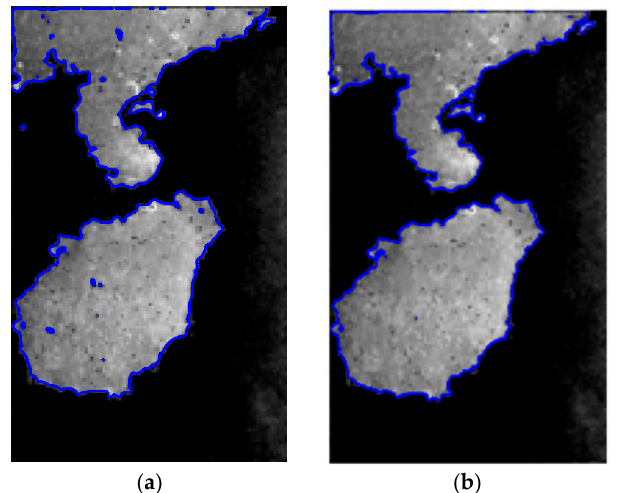
Figure 11. Comparison of whole block tracking: ( a ) Before block tracking ( b ) After block tracking.